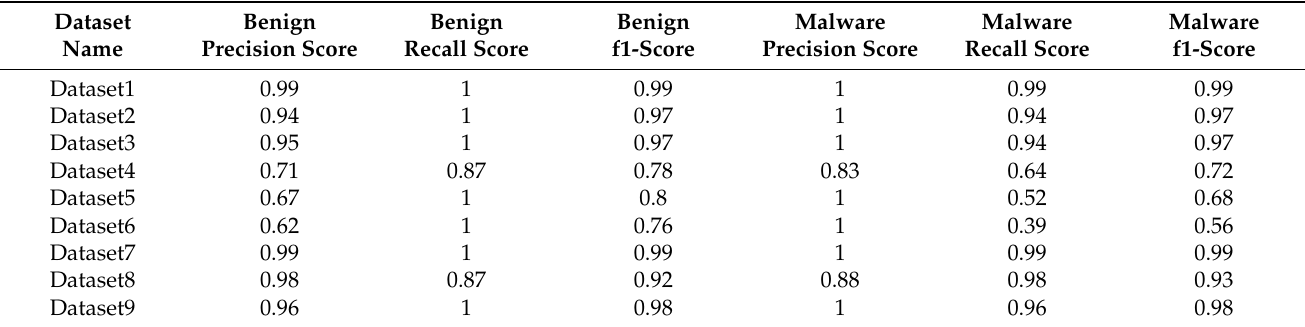
Table 4. Test results when using the decision tree algorithm.